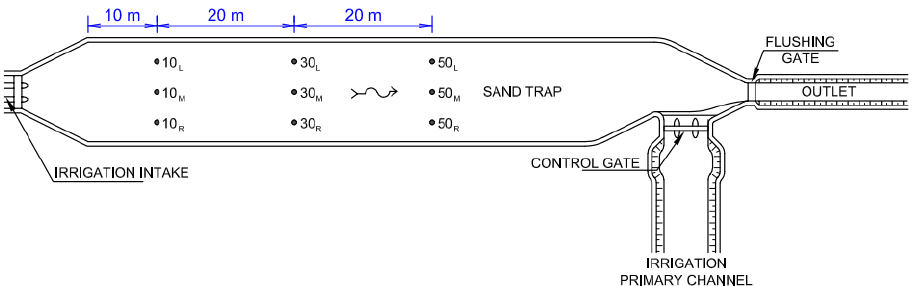
Figure 6. The layout for measuring the velocity showing nine measurement points (10 L , 10 M , 10 R , 30 L , 30 M , 30 R , 50 L , 50 M , and 50 R ). L, M, and R denote the left, middle, and right parts of the channel, respectively.